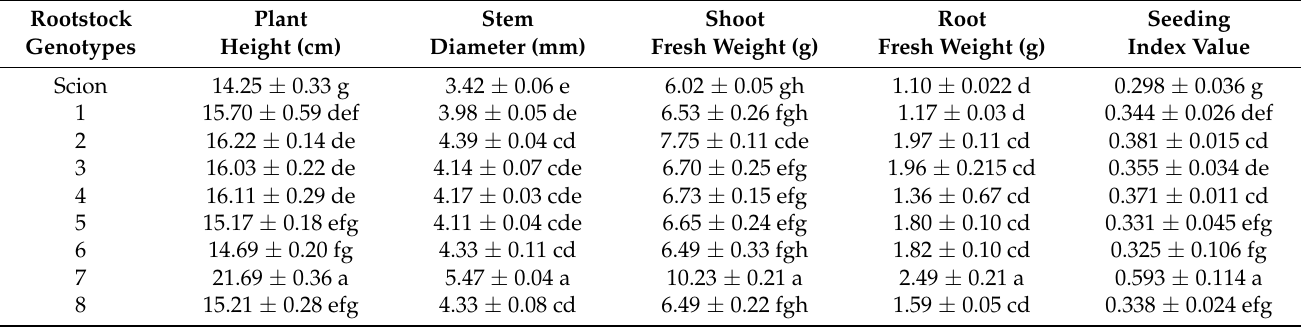
Figure 4. Salt injury of grafted rootstock seedlings (R1 to R15) and nongrafted rootstock seedlings (T1 to T15) under salt stress: ( a ) salt injury symptoms; ( b ) salt-injury index. The nongrafted scion “Mingzhi88” was used as a control. The salt-injury index was determined at 15 days after NaCl treatment (mean ± SEs), with 30 seedlings for each triplicate. The means within each column followed by different letters were significantly different among graft combination treatments, according to Tukey’s test ( p < 0.05). Table 4. Growth parameters of grafted tomatoes with the 15 rootstock genotypes under salt